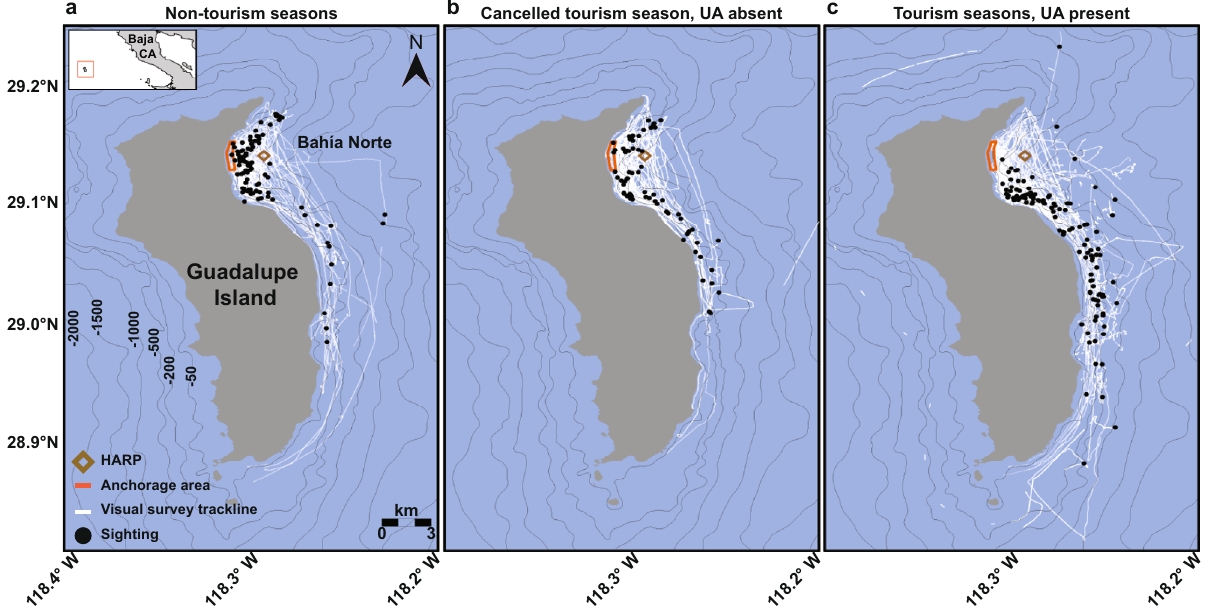
Fig. 1 Beaked whale sighting distributions. Maps of Guadalupe Island in the Mexican waters of the Paci fi c Ocean (inset), illustrating the sighting locations of Cuvier ’ s beaked whales (black circles) and visual search effort tracklines (white lines) from cetacean surveys conducted during a non-tourism seasons (spring 2017 and 2019) when cage diving boats were absent, b a canceled tourism season (summer/fall 2020) when cage diving boats were absent due to COVID-19 restrictions, and c tourism seasons (summer/fall 2018 and 2019) when cage diving boats operating ultrasonic antifouling (UA) systems were present. The location of the sea fl oor-mounted acoustic recorder (HARP) within Bahía Norte is denoted by a brown diamond in each plot, and the anchorage area used by tourist vessels for cage diving activities is outlined in orange. Depth contours are indicated by gray